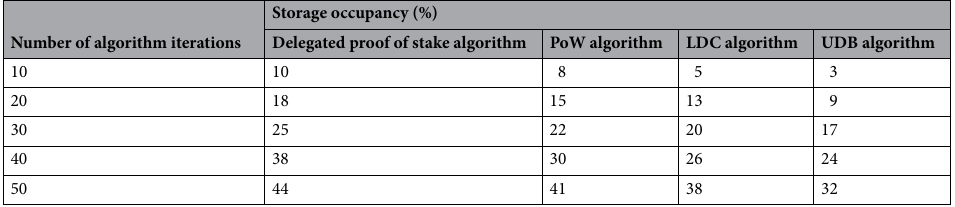
Table 4. Storage